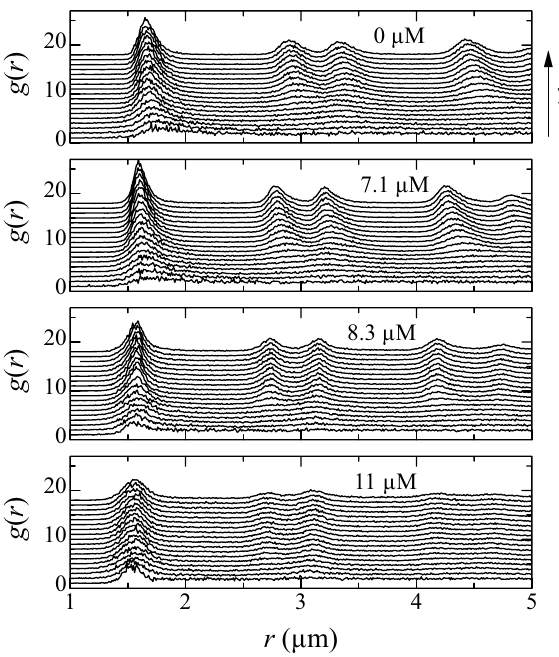
Figure 4. Two-dimensional radial distribution functions in the first layer.